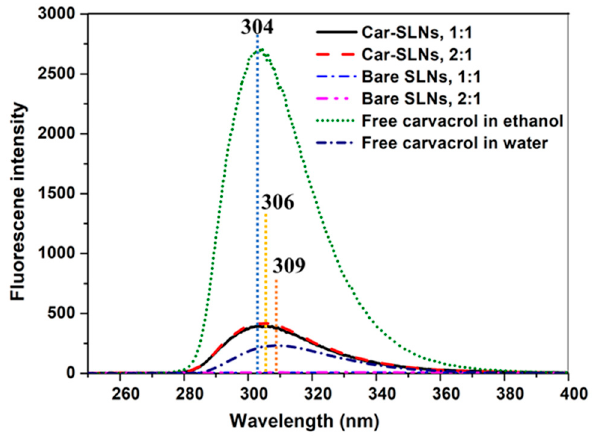
Figure 2. Fluorescence spectra of Car-SLNs with a carvacrol loading at 30% mass of lipids and a PGMP:GMS mass ratio of 2:1 or 1:1 and the corresponding bare SLNs without carvacrol, and carvacrol pre-dissolved in ethanol and water.